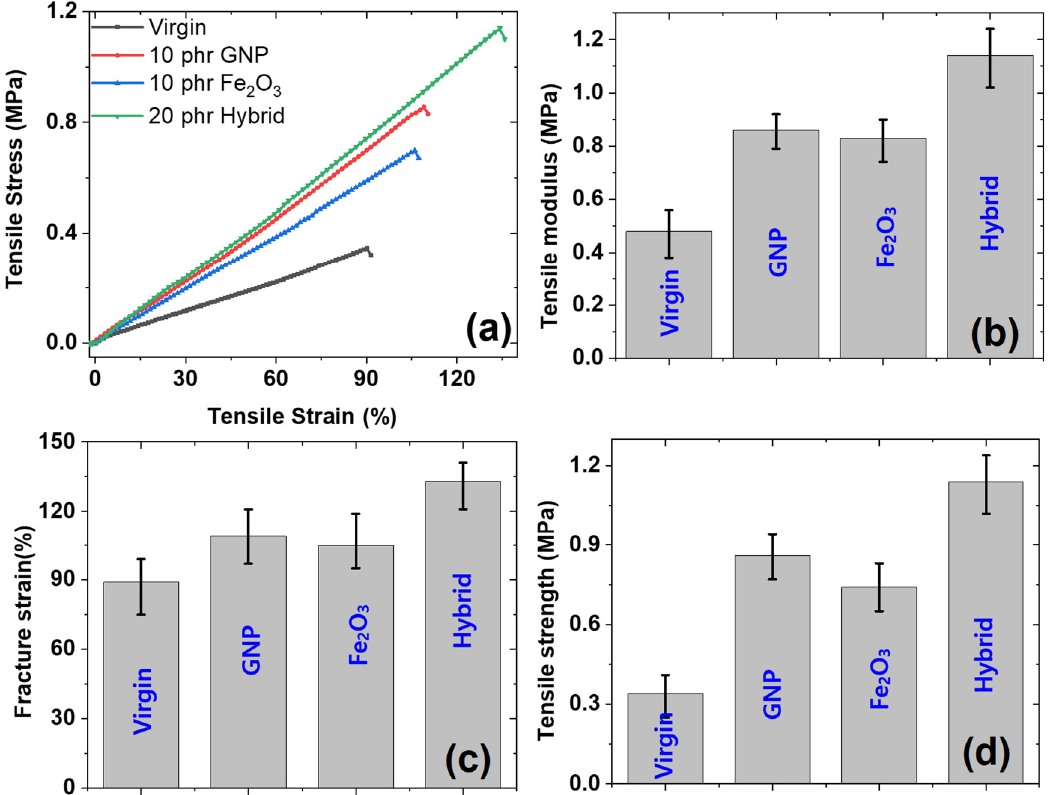
Figure 7. Tensile mechanical properties; ( a ) profiles of stress–strain of different composites, ( b ) tensile modulus for different composites, ( c ) fracture strain of different composites, ( d ) tensile strength of the composites.